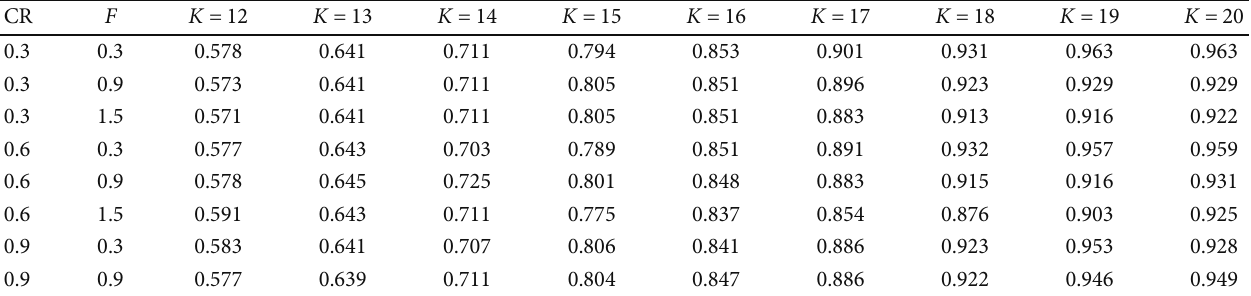
Table 3: The average accuracy of the clustering results of each clustering number k obtained by the proposed algorithm on the dataset 2d- 20c with di ff erent combinations of crossover probability Cr and scaling factor F .